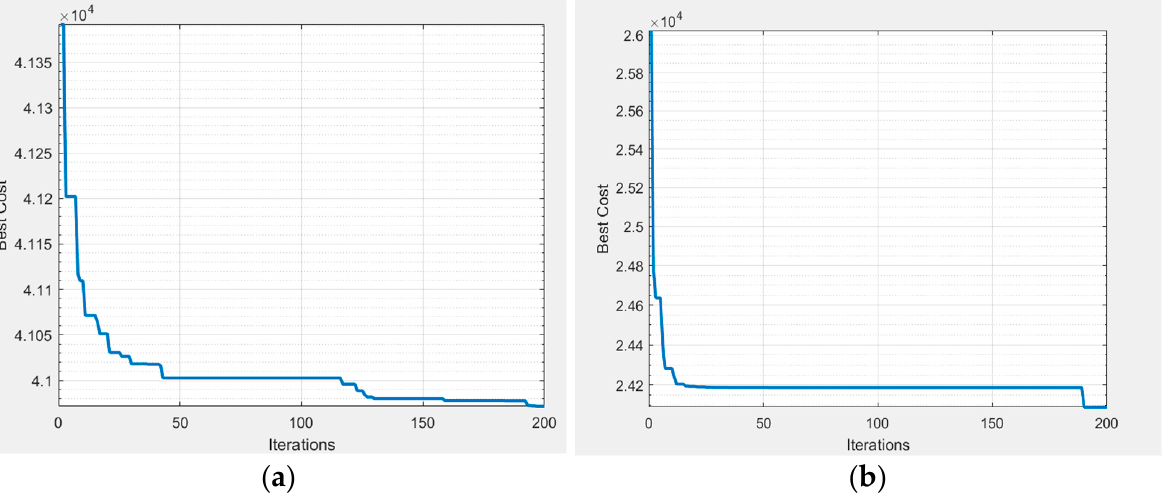
Figure 8. Obtained best cost results obtained from the proposed energy management method with GA: ( a ) case1; ( b ) case2.